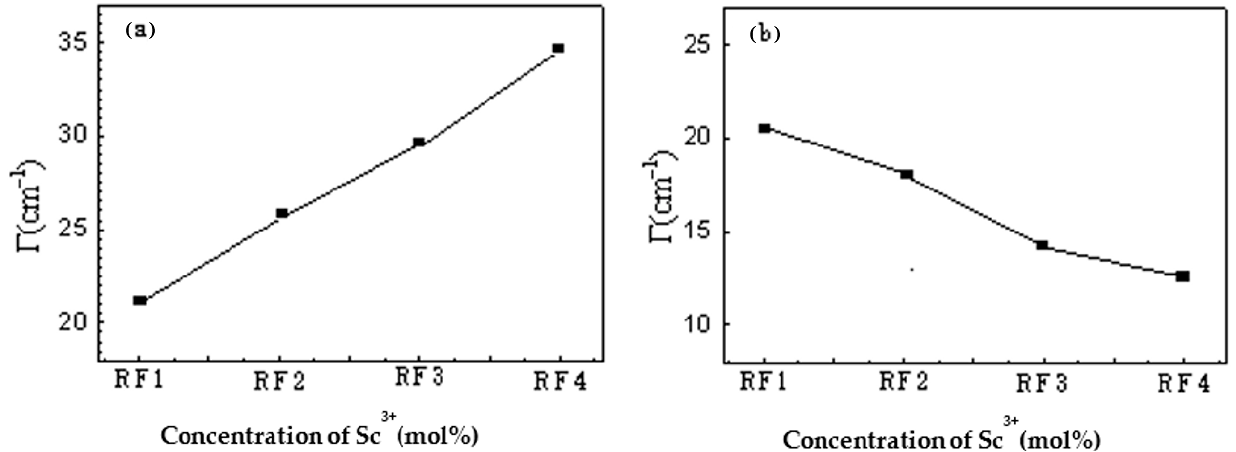
Figure 3. Change in exponential gain coefficient Γ : ( a ) Kr + laser (476 nm blue light) and ( b ) He-Ne laser (633 nm red light).